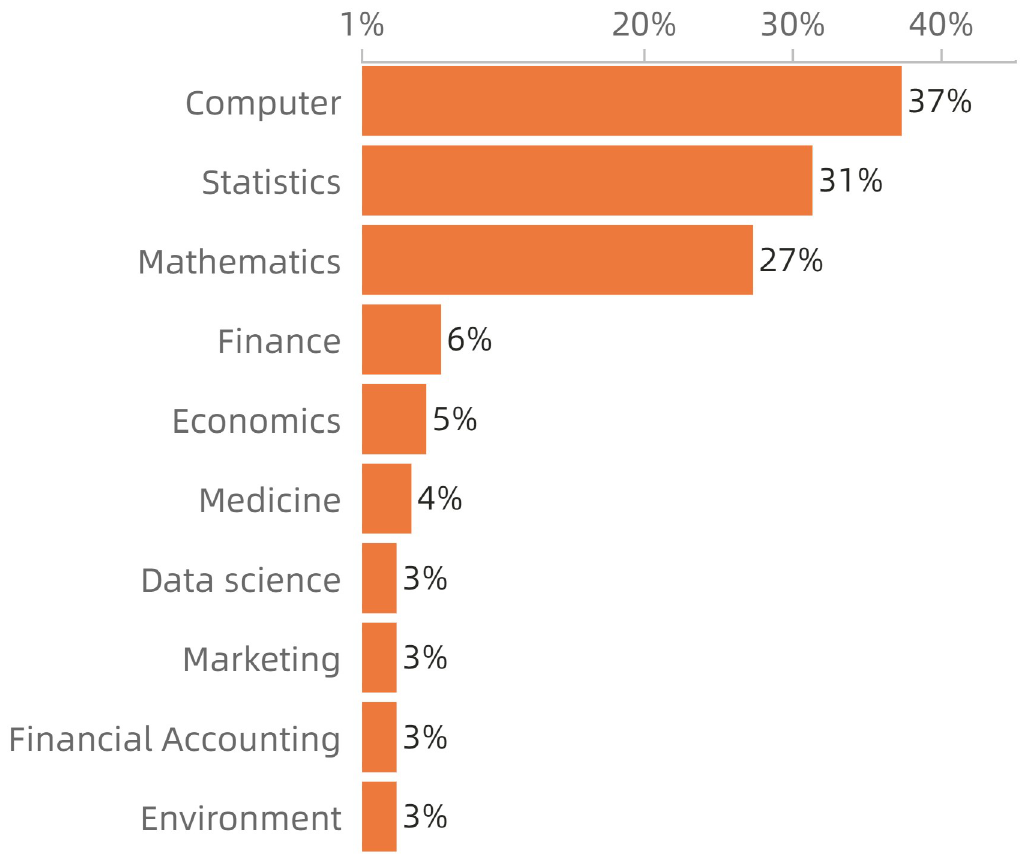
Fig 7. Order of ratio of professions requirement in